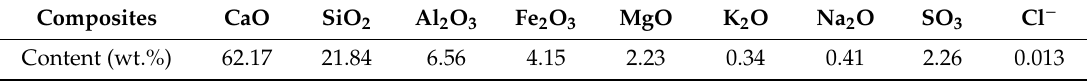
Table 2. Cement chemical composite.